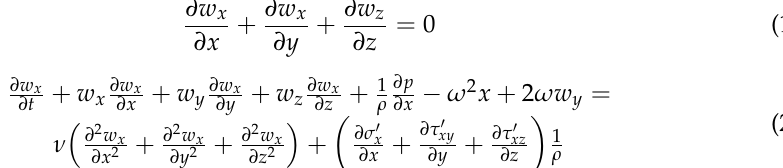
Figure 10. Performance curves of the model pump.